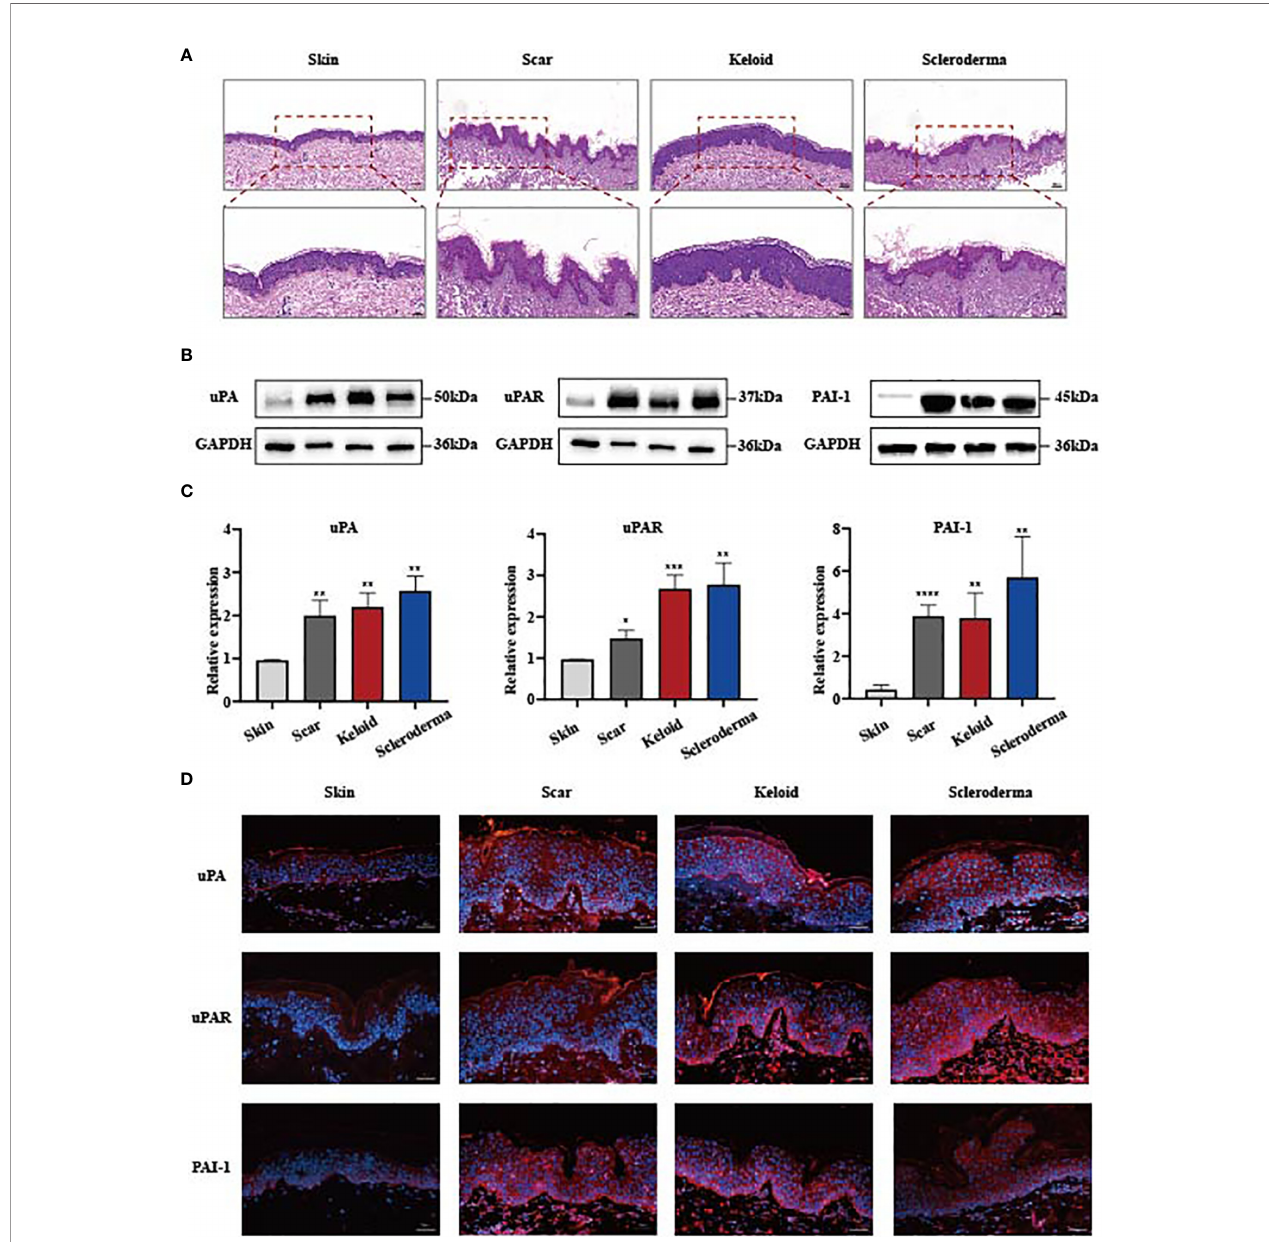
FIGURE 1 | uPA, uPAR and PAI-1 are frequently upregulated in skin fi brosis. (A) Haematoxylin and eosin staining of human normal and fi brotic tissues. Scale bars, 100 m m, 50 m m. (B, C) The protein level of uPA, uPAR and PAI-1 in normal and fi brotic tissues analyzed by the western blot assay. GAPDH was the internal reference. Hypertrophic scars, n=5; keloids, n=4; systemic sclerosis, n=7. (D) Immuno fl uorescence staining of uPA, uPAR and PAI-1 in normal and fi brotic tissues. Scale bars, 100 m m. *P < 0.05, **P < 0.01, ***P < 0.001, and ****P < 0.0001 when compared between the denoted